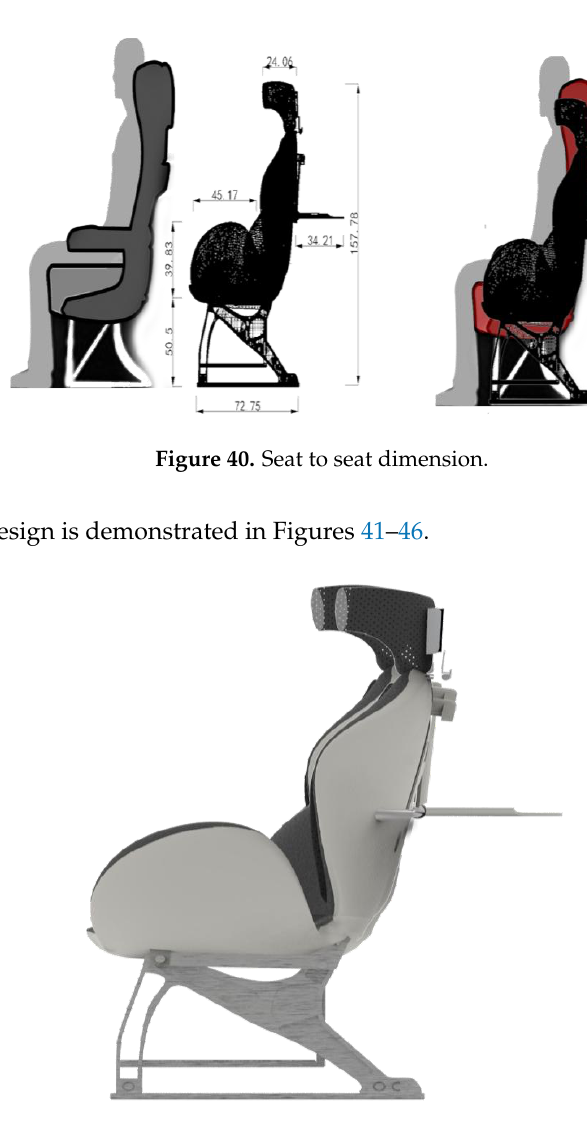
Figure 39. Side dimension.